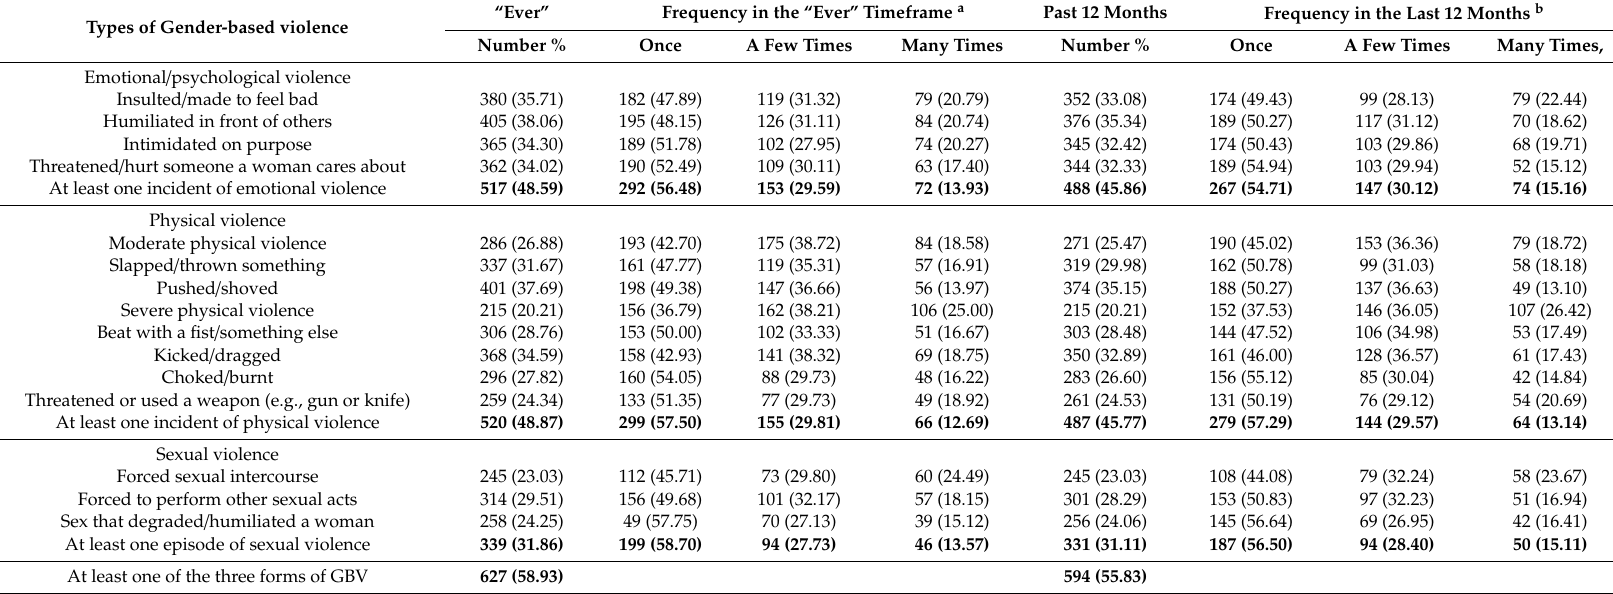
Table 2. Type and prevalence of GBV perpetrated by male high school students in the “ever” timeframe and over the previous 12 months, eastern Hararghe, eastern Ethiopia, December